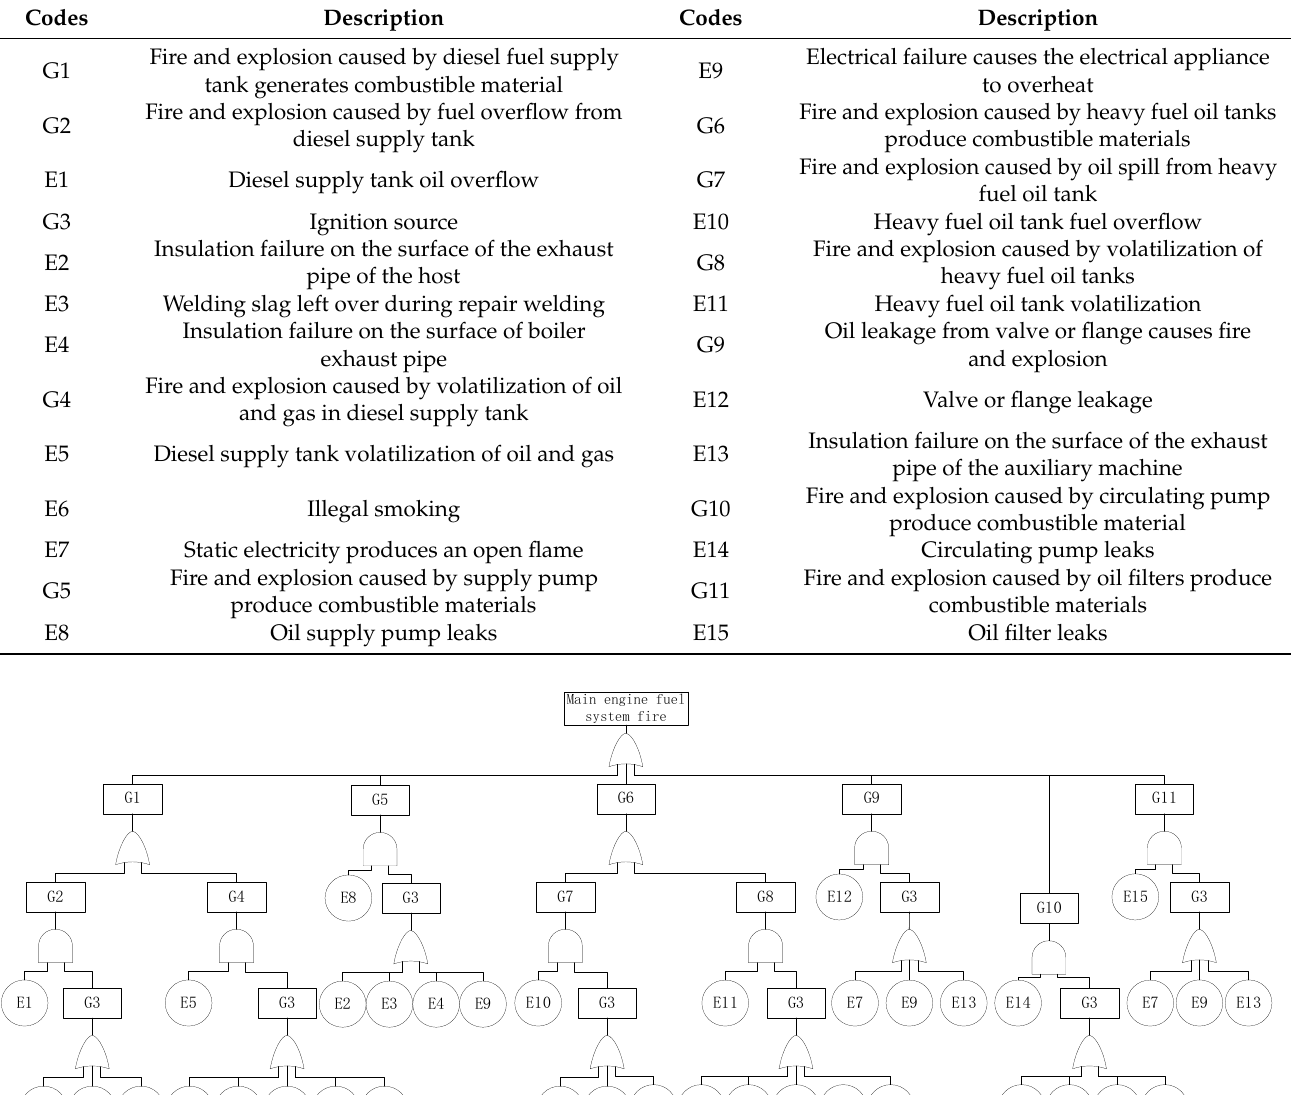
Table 7. Logic gates and principal events of a main engine fuel system fire.